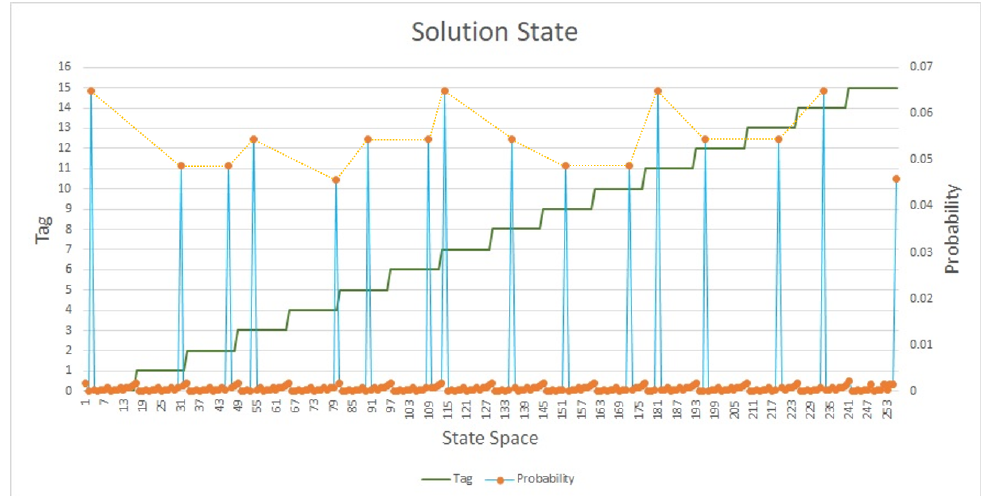
Figure 11. Results of a sample execution of QiBAM on QX Simulator, which matches the results derived analytically in Figure